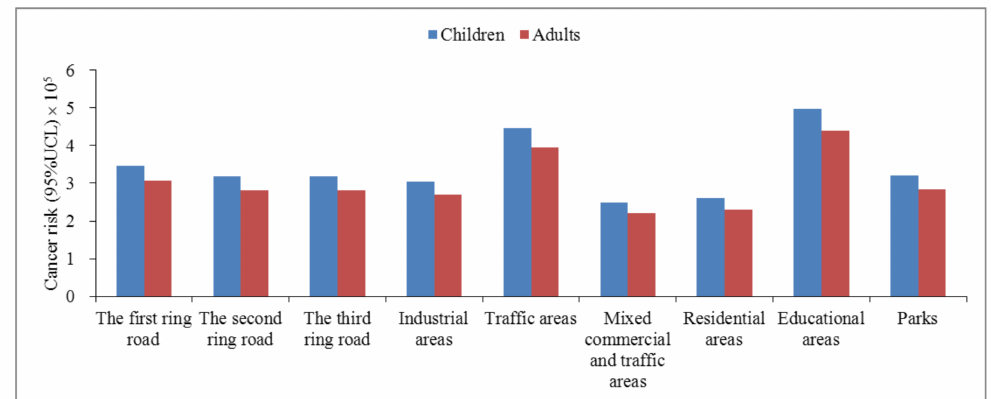
Figure 2. Cancer risk of human exposure to PAHs from urban soil in urban functional areas of